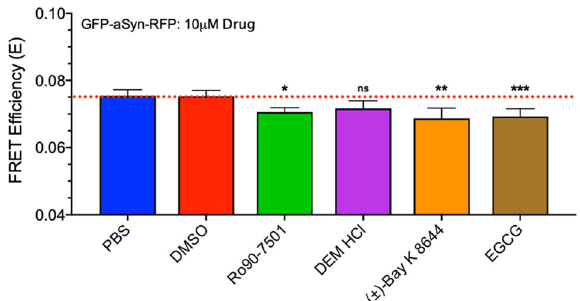
Fig. 7 FRET response to pilot HTS hits on intra-protomeric α SN biosensor. Hits that demonstrated robust, reproducible FRET response in the inter-protomeric biosensor CRC were then evaluated with the intra-protomeric α SN biosensor. With both donor and acceptor XFP fused to one construct, this biosensor is sensitive to both oligomer formation as well as conformation. Three hits reduced the intra-protomeric FRET (RO, BAY, DEM) signi fi cantly, as did known α SN modulator EGCG. Experiments were performed